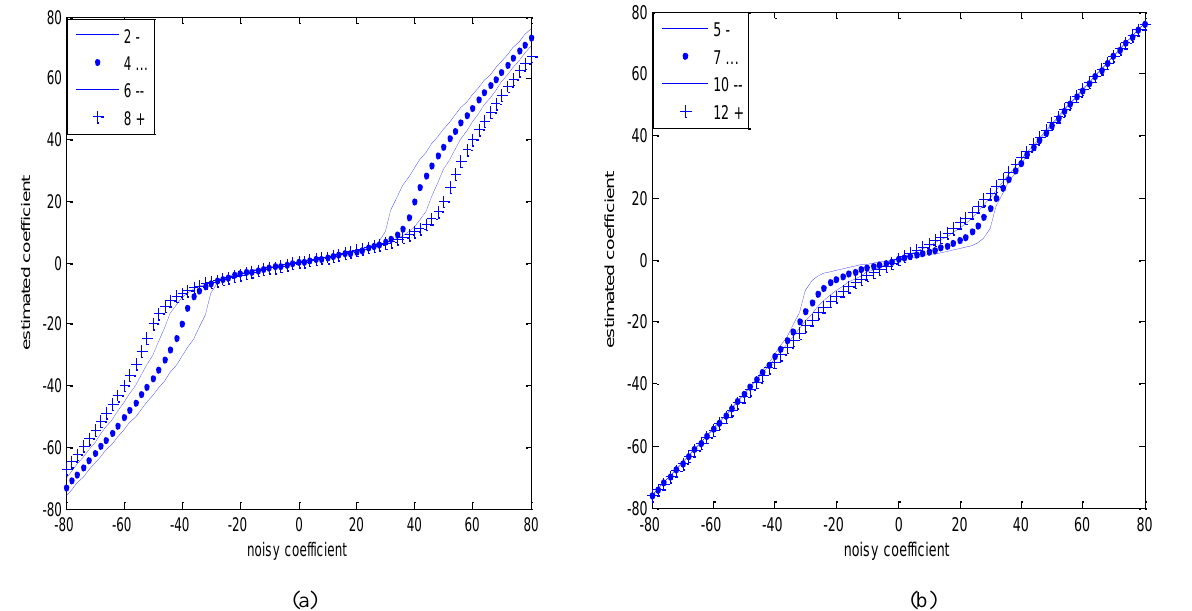
Figure 4. MAP estimator as a function of noisy coefficient when using the student-t distribution as the prior probability of wavelet coefficients a) influence of the degrees of freedom, b) influence of scale parameter 